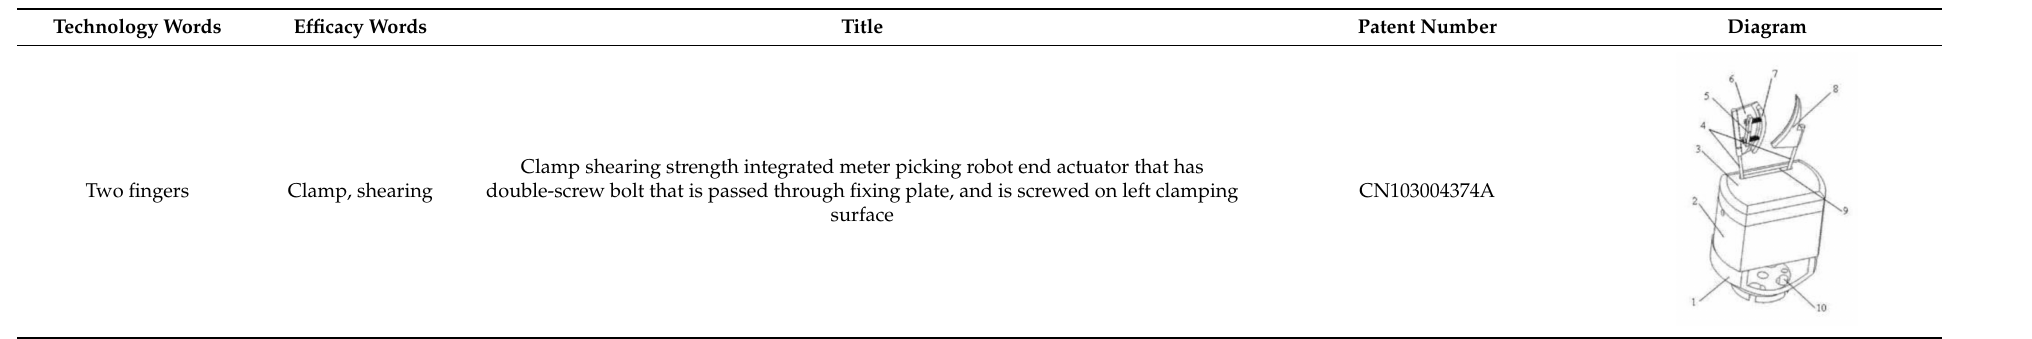
Table 6. Grabbing and cutting modes for spherical